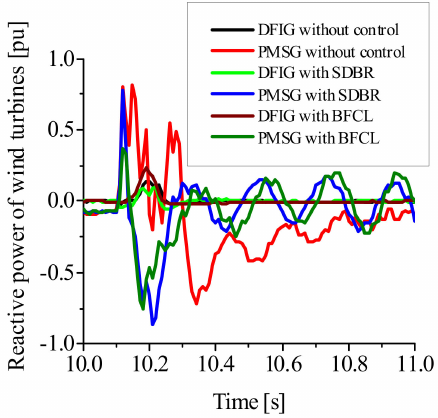
Figure 17. Reactive power of the wind turbines.